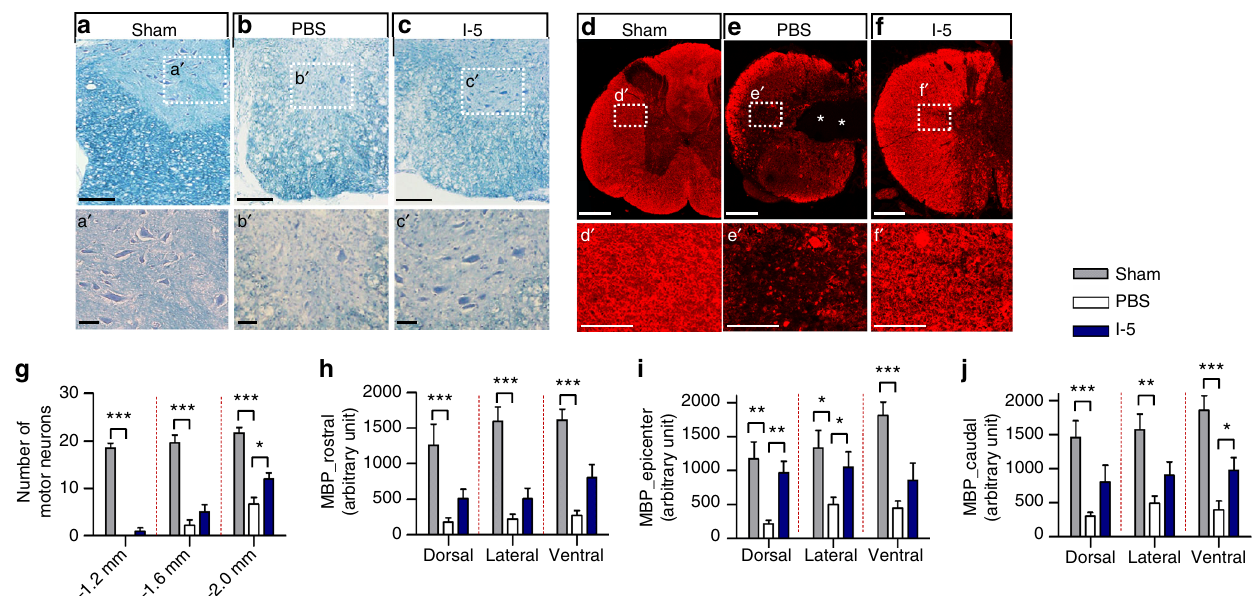
Fig. 9 I-5 injection preserves motor neurons and myelinated white matter. a – c Representative images of the ventromedial region in transverse spinal cord sections 1.6 mm caudal to the epicenter from animals in sham-operated ( a ), PBS ( b ) and I-5 ( c ) injection groups. The sections were stained with eriochrome cyanine and cresyl violet. Boxed regions in a – c are magni fi ed in a ʹ – c ʹ . Surviving motor neurons were more frequently observed in the I-5 than PBS injection group. Scale bars represent 200 µ m in a – c and 50 µ m in a ʹ – c ʹ . d – f Representative images of MBP immunostaining in transverse spinal cord sections of the lesion epicenter from animals in sham-operated ( d ), PBS ( e ) and I-5 ( f ) groups. Boxed regions in d – f are magni fi ed in d ʹ – f ʹ . Scale bars represent 500 µ m in d – f and 50 µ m in d ʹ – f ʹ . g Quantitative comparison of the number of motor neurons. h – j Graphs showing quanti fi cation of the fl uorescence intensity of MBP immunoreactivity. Quanti fi cation was performed in the sections located 2 mm rostral ( h ) to the epicenter, at the epicenter ( i ), and 2 mm caudal ( j ) to the epicenter. At each level, three ROIs were selected: one each in dorsal, lateral, and ventral white matter. *, ** and *** indicate p < 0.05, p < 0.01 and p < 0.001, respectively, by one-way ANOVA followed by Tukey ’ s post hoc analysis. N = 5, 9 and 8 for the sham-operate, PBS and I-5 groups, respectively. Error bars represent the